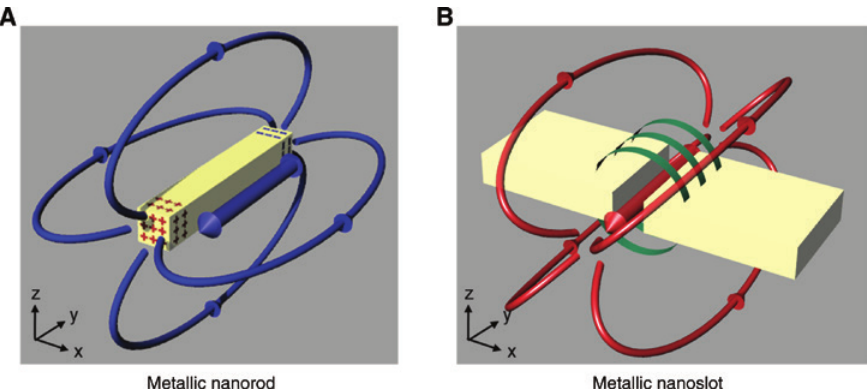
Figure 6: Optical rod and slot antenna. (A) Schematics of optical rod antenna as an electric dipole. ( + ) and (−) signs represent electron and hole charges, respectively. The blue arrow beside a metallic nanorod shows a virtual electric dipole formed in a metallic rod and the blue curved arrows show virtual E-field lines forming a loop generated by charge distributions in the nanorod. (B) Schematics of optical slot antenna as a magnetic dipole. Green arrow lines represent virtual current loops formed in a nanoslot and the red arrow shows the resultant virtual magnetic dipole due to the current loops. Red curved arrows show virtual H-field lines forming a loop generated by virtual magnetic dipole inside the